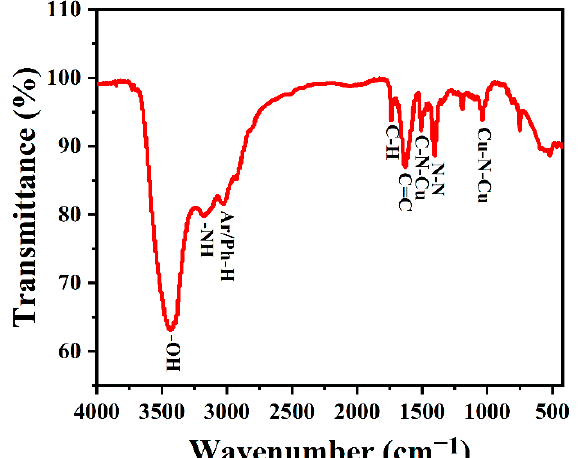
Figure 5. FTIR spectra of Cu-CDs.